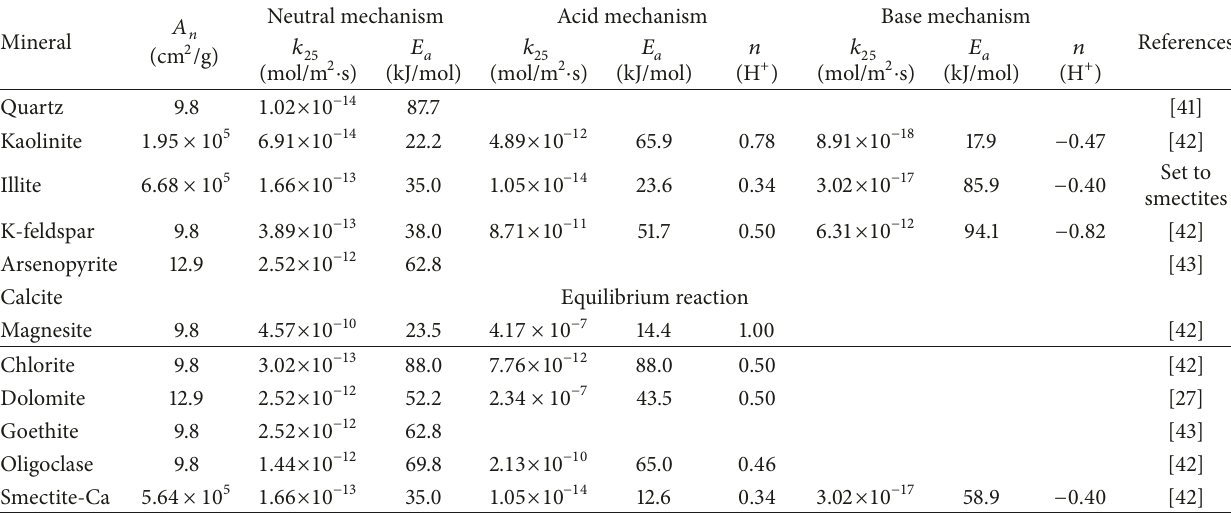
Table 4: Kinetic data for selected primary and secondary minerals. Only calcite was treated similar to the equilibrium reaction, and the rest of the minerals were kinetically treated with consideration of neutral, acid, and base mechanisms. 𝐴 𝑛 Mineral (cm 2